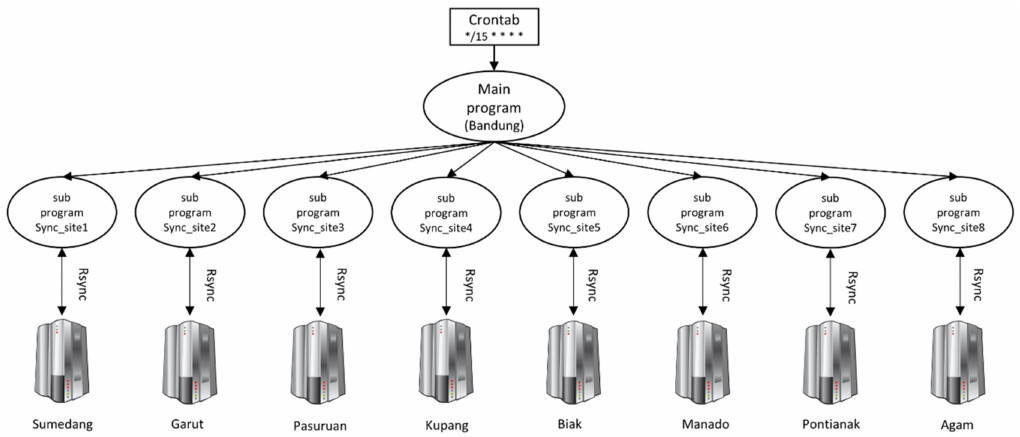
Figure 3. The synchronization process between the central and site